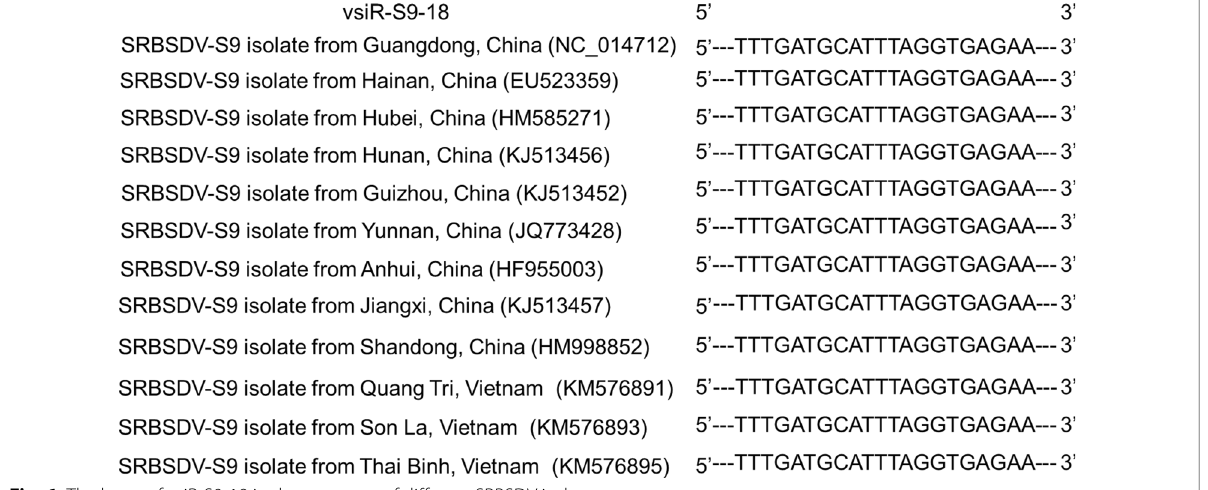
Fig. 6 The locus of vsiR-S9-18 in the genomes of different SRBSDV